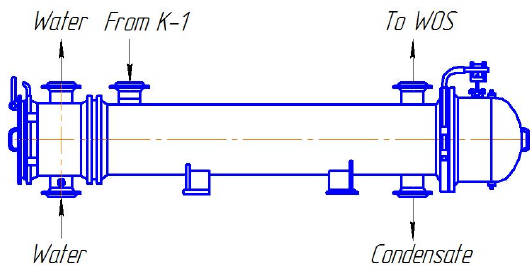
Figure 6. General view of the condenser KP-1. The condenser parameters are presented in Table 4.